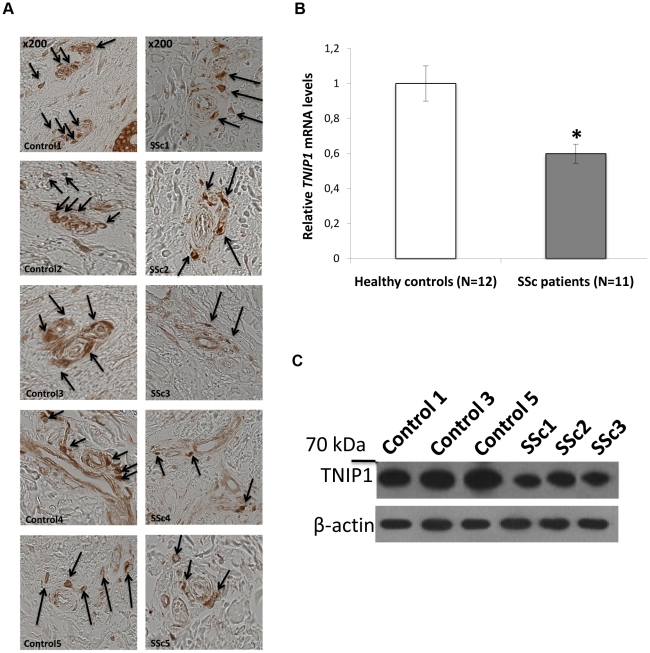
Decreased TNIP1 expression in SSc patients.(A) Expression of the TNIP1 protein was decreased ex vivo in SSc lesional skin tissue compared to controls (arrows indicate TNIP-1 positive cells). Shown are representative sections of the 5 patients and controls included in the analysis. (B) Consistent with these findings, a 1.7-fold decrease of TNIP1 mRNA levels was observed in dermal fibroblasts from SSc patients (* indicates a P-value = 0.001 vs. controls). These results were confirmed at the protein level (C).